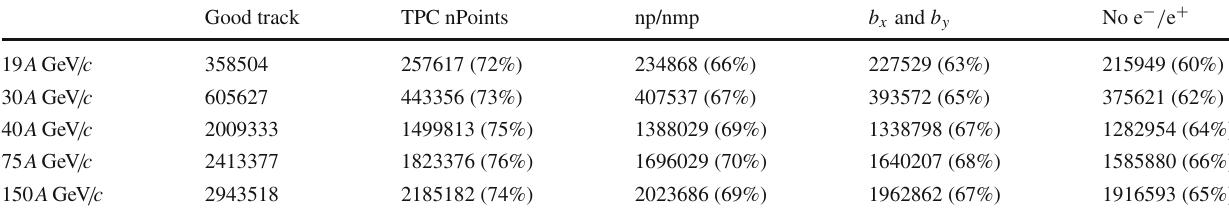
Table 2 Number of tracks before and after cuts for the 5% most central Be + Be collisions. See text for explanation of the